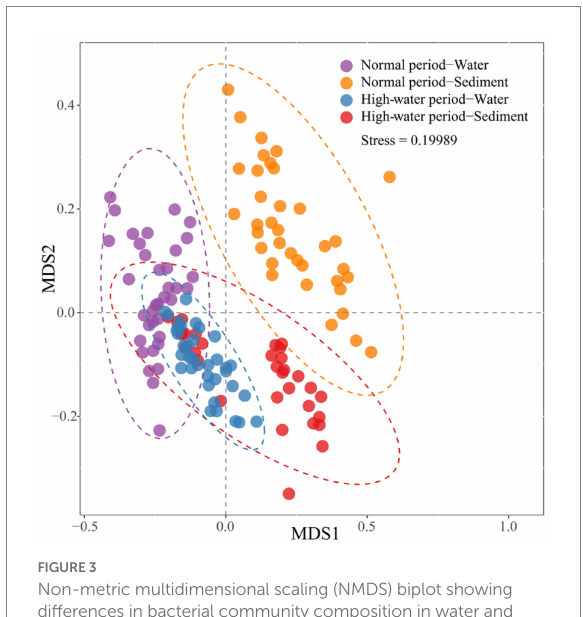
FIGURE 3 Non-metric multidimensional scaling (NMDS) biplot showing differences in bacterial community composition in water and sediment samples of Baihe River across normal and high-water